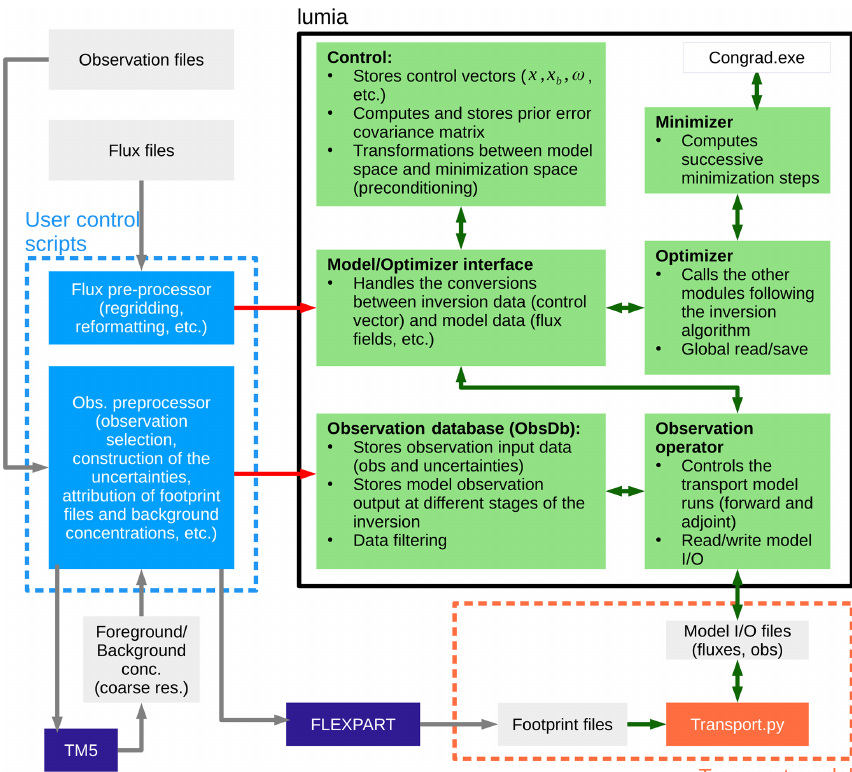
Figure 1. Inversion flow diagram. The green boxes represent code that is part of the lumia Python module; the orange box shows operations performed by the atmospheric transport model (in our case a simple Python script that reads in observations, fluxes and footprints, but a full transport model could be plugged in instead); the blue boxes show code that is typically user- and application-specific (pre-processing of data and main inversion control script). The boxes in grey mark on-disk data, and the boxes in purple show external